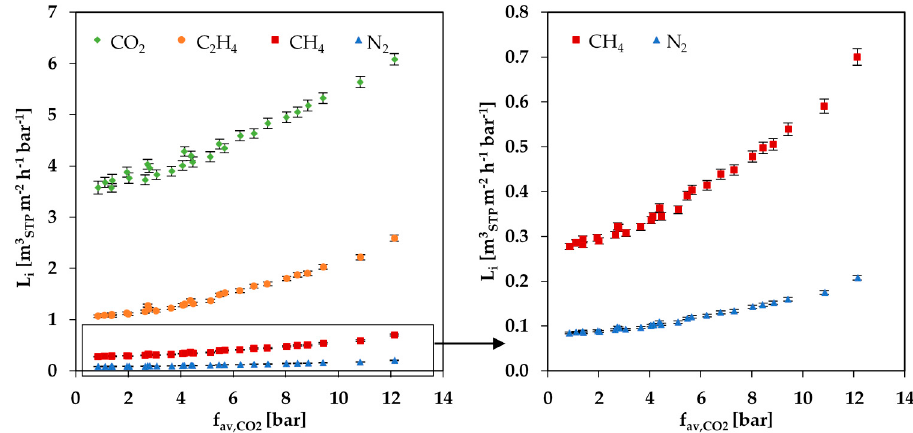
Figure 6. Permeances of gas mixture components depending on the average CO 2 fugacity at 25 °C for measurement series at feed pressures of 10, 20 and 30 bar.